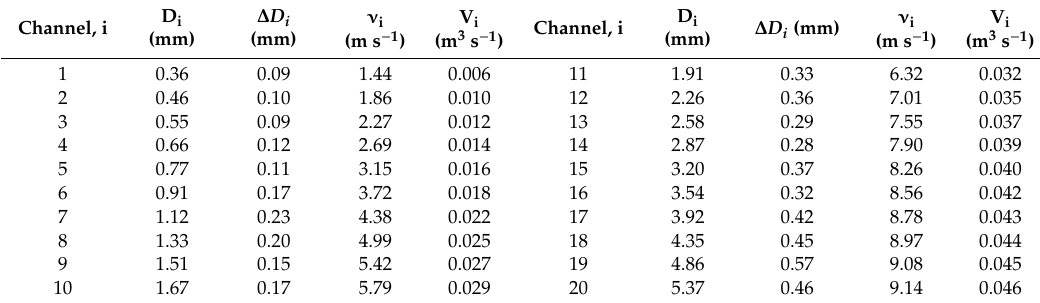
Table 3. Mean diameter D i (mm), diameter interval ∆ D i (mm), and fall velocity ν i (m s − 1 ), and sampling volume V i (m s − 1 ) for 20 channels of JWD